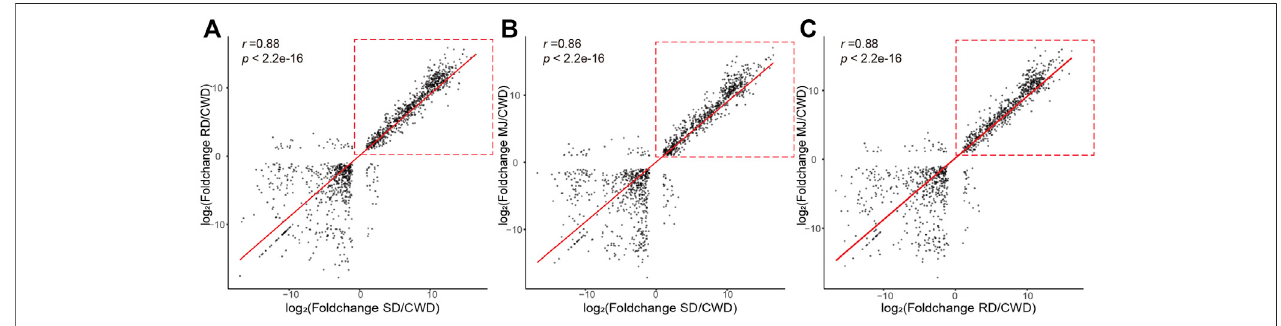
FIGURE 2 | Correlation of the DEG sets (|log 2 FoldChange| ≥ 1 and adjusted p value < 0.01) of the ATDs relative to Chinese water deer: (A) SD/CWD vs RD/CWD, (B) SD/CWDvsMJ/CWD,and (C) RD/CWDvsMJ/CWD.Notethatthehighcorrelationswereduemainlytotheupregulatedgenes(red-dottedboxes).RD:reindeer,SD: sika deer, MJ: muntjac, and CWD: Chinese water